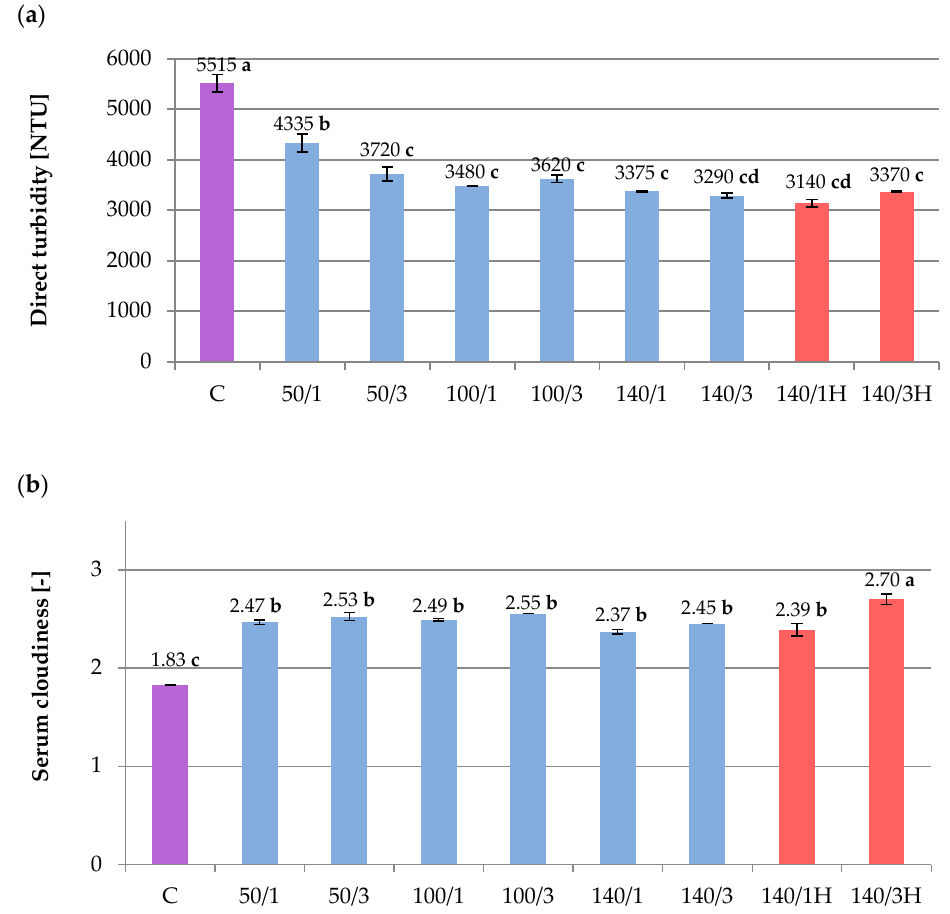
Figure 1. Influence of HPH processing on beetroot juice parameters: ( a ) Direct turbidity (NTU). ( b ) Serum cloudiness (absorbance at 660 nm). C—control; 50/1, 50/3, etc.,—pressure/number of cycles; H—samples without cooling. The values with different letters are significantly different ( p < 0.05).